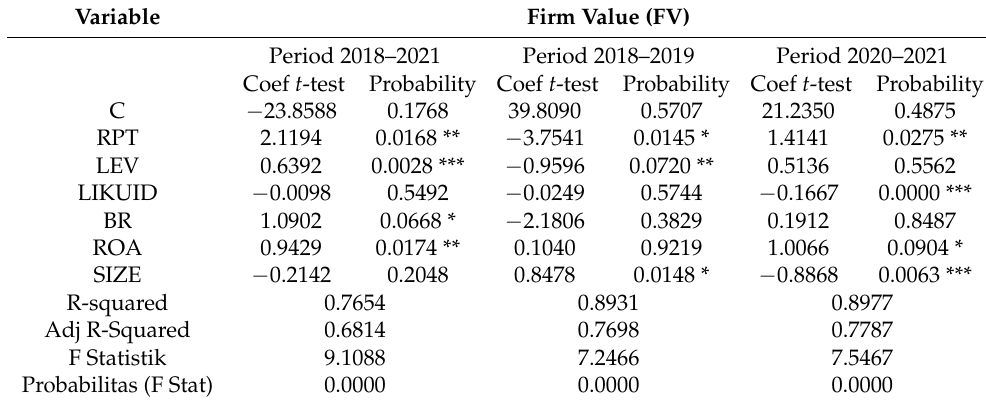
Table 5. Regression Test